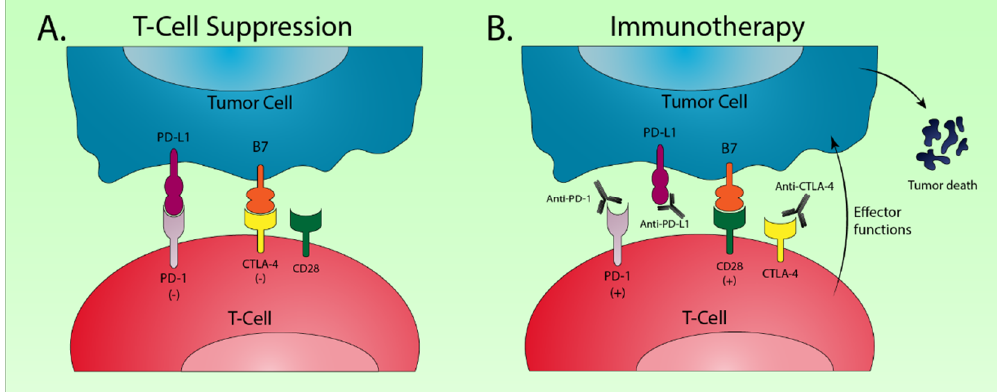
Figure 3. Schematic drawing of the major molecular mechanisms involved in checkpoint blockade for cancer immunotherapy. ( A ) Interaction of the programmed death 1 (PD-1) receptor on T-cells with the programmed death ligand 1 (PD-L1) on tumor cells results in T-cell suppression [148]. A similar suppressive interaction occurs between B7 on tumor cells and cytotoxic T lymphocyte-associated antigen 4 (CTLA-4) on T-cells [149]; ( B ) Monoclonal antibodies targeting PD-1 and PD-L1 disrupt T-cell checkpoint suppression and facilitate antitumor T-cell e ff ector functions. Anti-CTLA-4 therapy allows binding of B7 with CD28 on T-cells which stimulates further T-cell